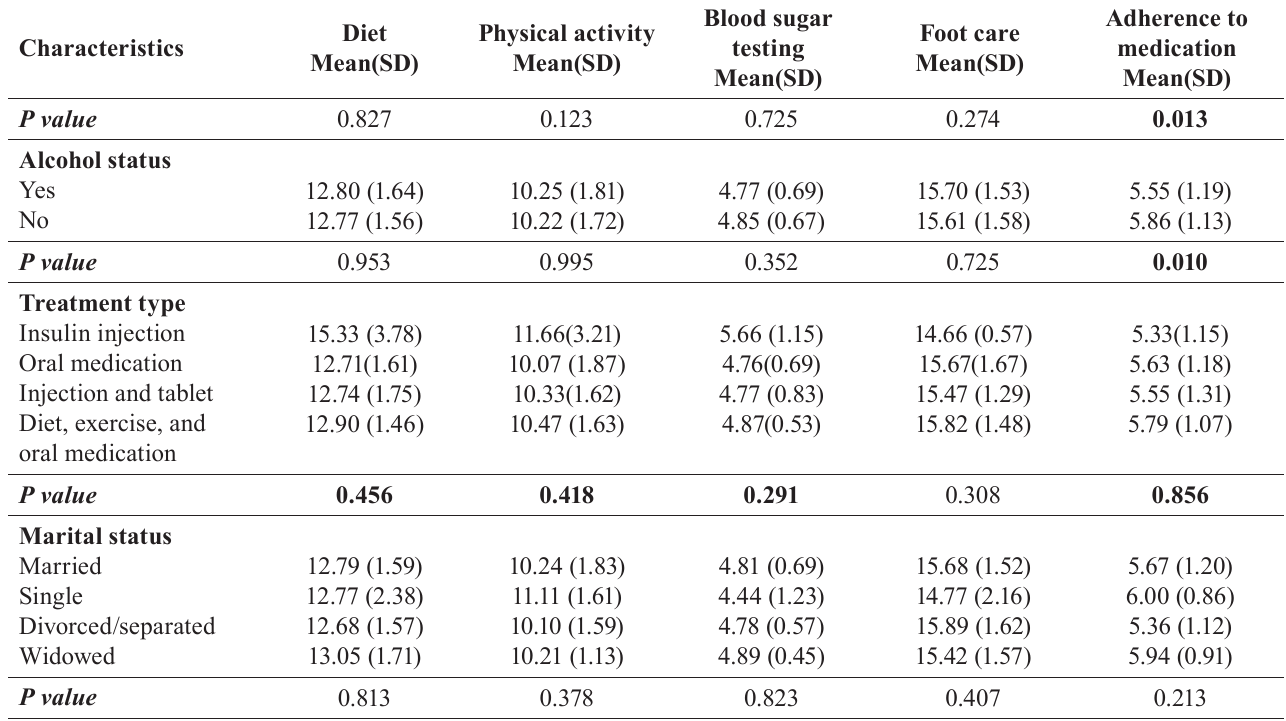
TABLE V - F actors associated with the Summary of Diabetes Self-Care Activities domains